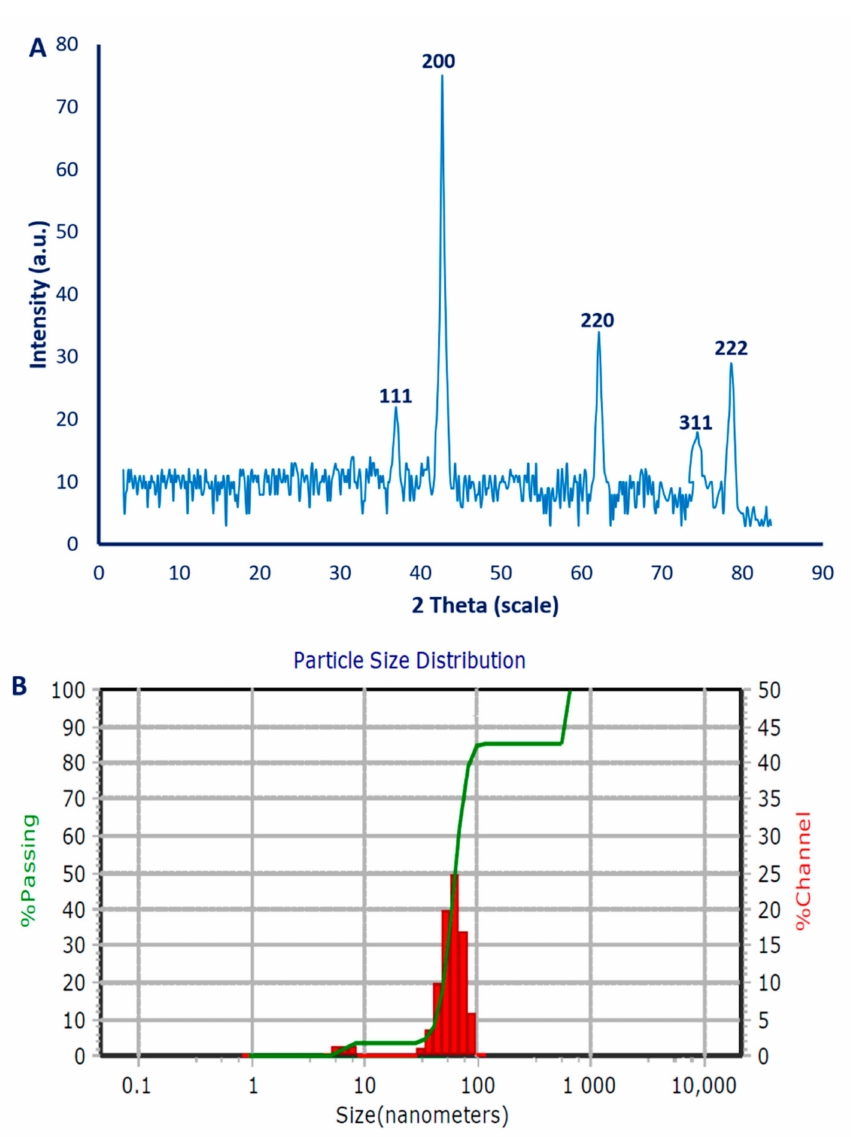
Figure 7. ( A ) The XRD analysis of the crystallographic structure; ( B ) the DLS analysis of biogenically synthesized